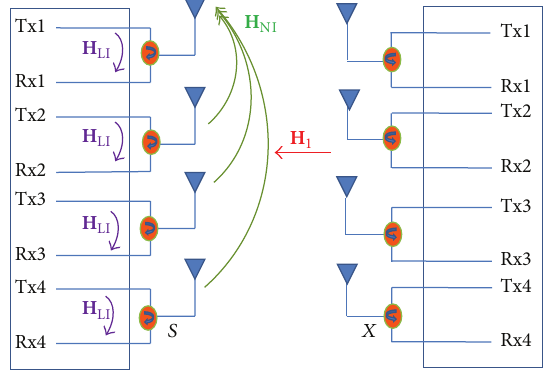
Figure 5: Model of full-duplex single-channel 4 × 4 MIMO